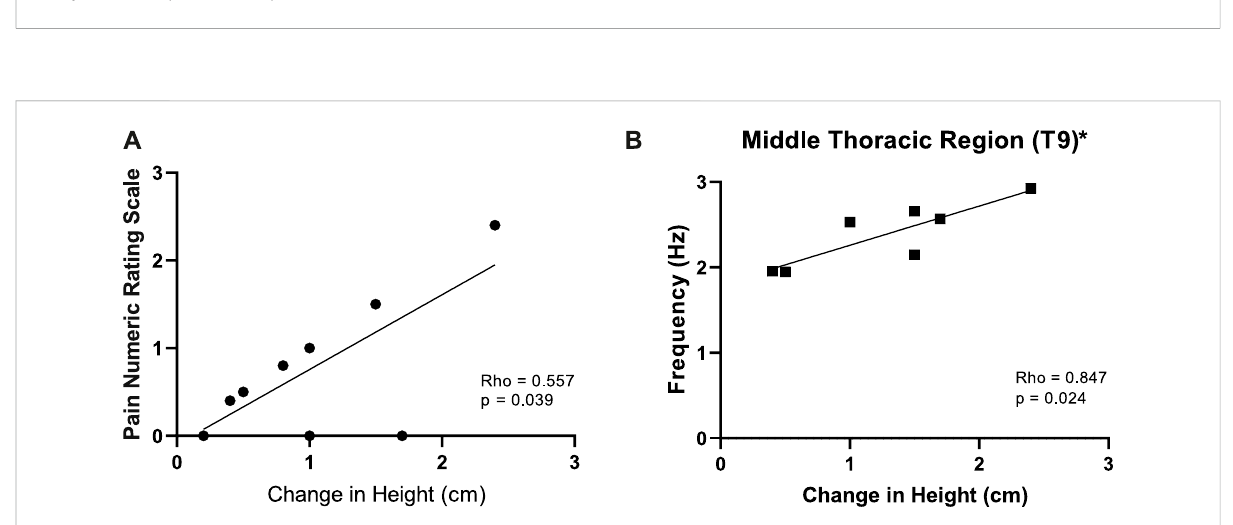
FIGURE 7 (A) : Mean (±SEM) back pain intensity (Numeric Rating Scale: 0 – 10: Max) scores after 1 (1 h), 6 h (6 h) Dry Immersion (DI), and 30 min after DI (RECOVERY). *Statistically signi fi cant ( p < 0.05) Wilcoxon signed-rank test. (B) : Subjective back pain locations as drawn by the seven (out of ten) subjects that reported back pain after 6 h